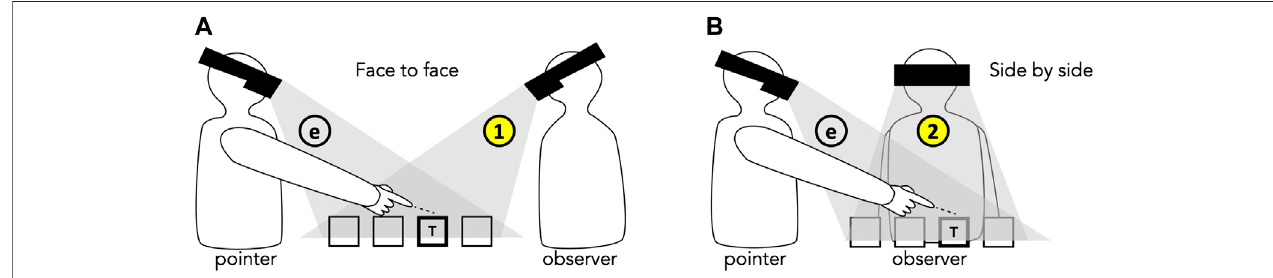
FIGURE2| Illustration oftheexperimental setup.Wemeasuretheobserver ’ sunderstanding( ➀ or ➁ )ofthespatialreferencesproduced bythepointer. ⓔ denotes the pointer ’ s egocentric perspective. (A) : A face-to-face layout. (B) : A side-by-side layout. This setup simulates a group of people surrounding shared small-scale AR content (e.g., an AR-based board game, medical